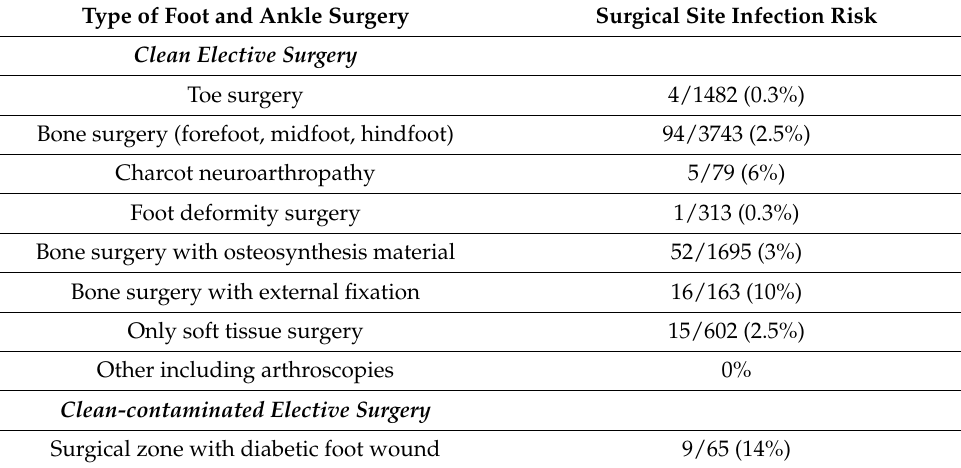
Table 2. SSI risk according to the type of surgery.